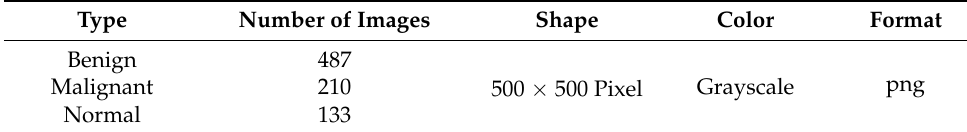
Table 1. Details of breast cancer dataset.